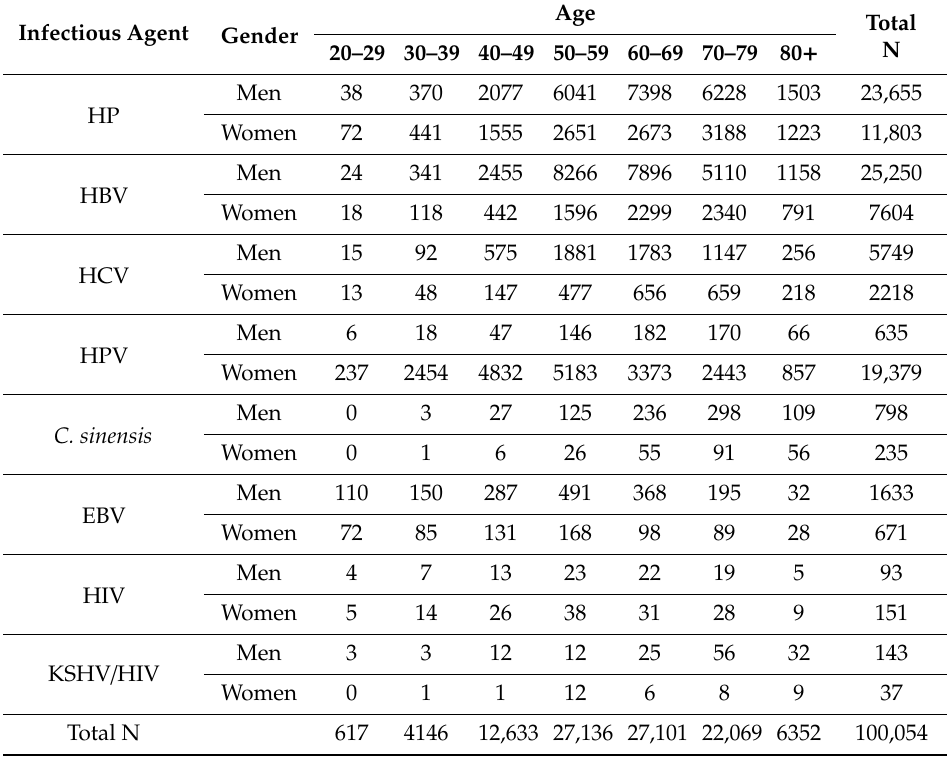
Table 1. The estimated number of cases of infection-related cancers according to infectious agent in 2014, South